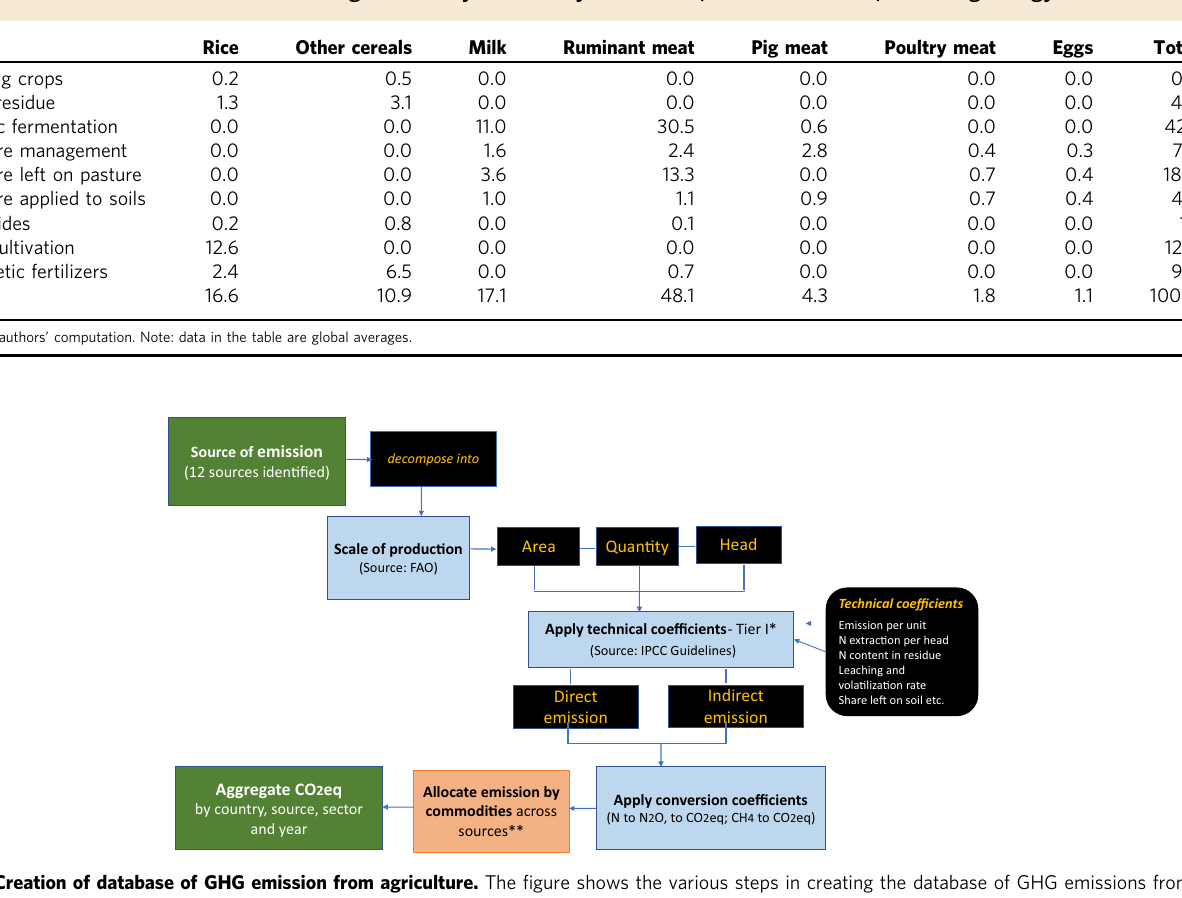
Table 5 Shares of GHG emissions from agriculture by commodity and source, 2015 (% of total, excluding energy).